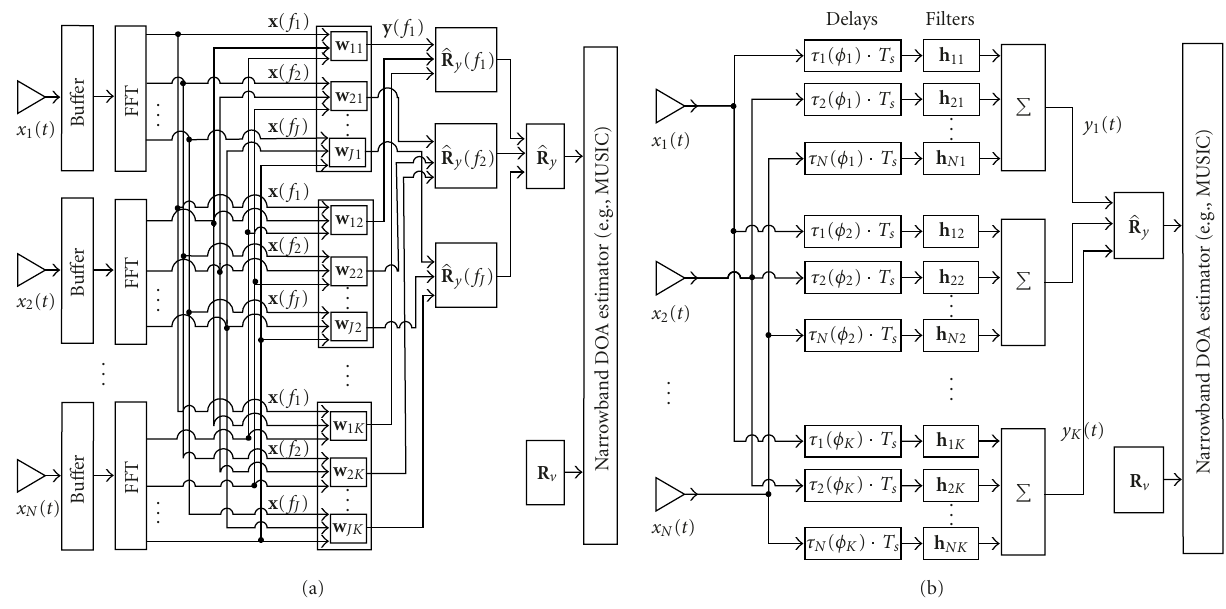
Figure 2: Broadband DOA estimation using CMRBs. (a) Frequency-domain processing structure. (b) Time-domain processing